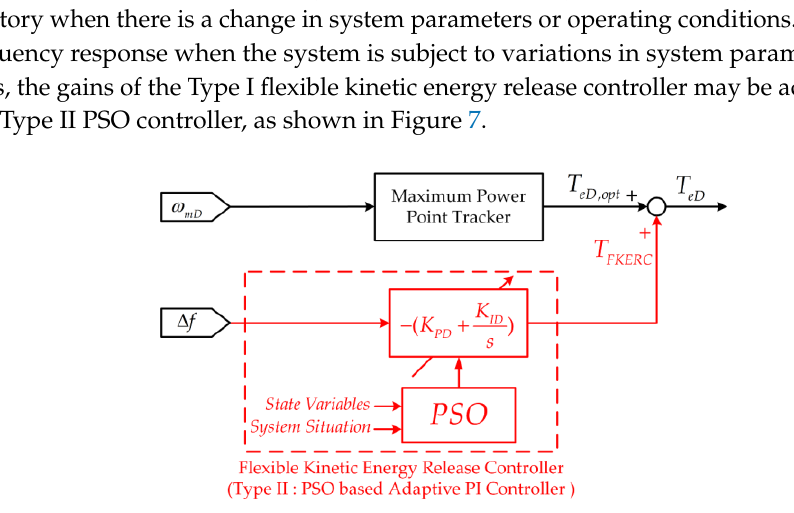
Figure 7. Particle swarm optimization (PSO) based adaptive Proportional-Integral (PI) controller.